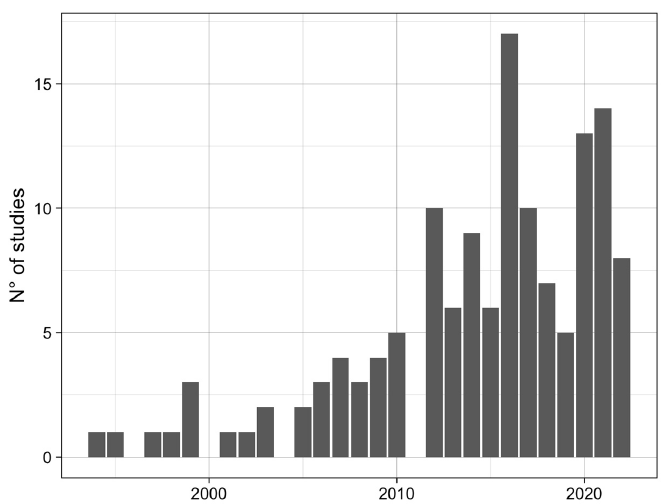
Figure 2. Number of studies on the detection of bacteria in ticks, belonging to the families Anaplas- mataceae , Rickettsiaceae and Coxiellaceae , published from 1992–2022.